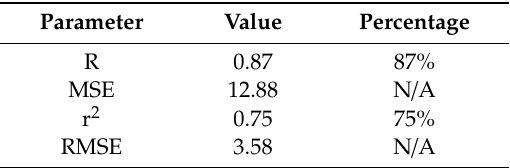
Table 4. Performance